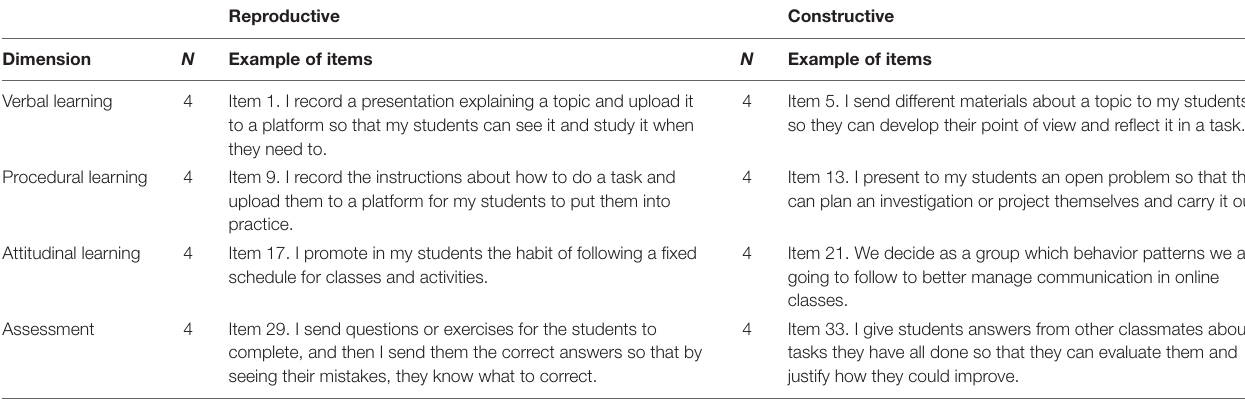
TABLE 1 | Structure and examples of questionnaire items. Reproductive Constructive Dimension Example of items N Example of items